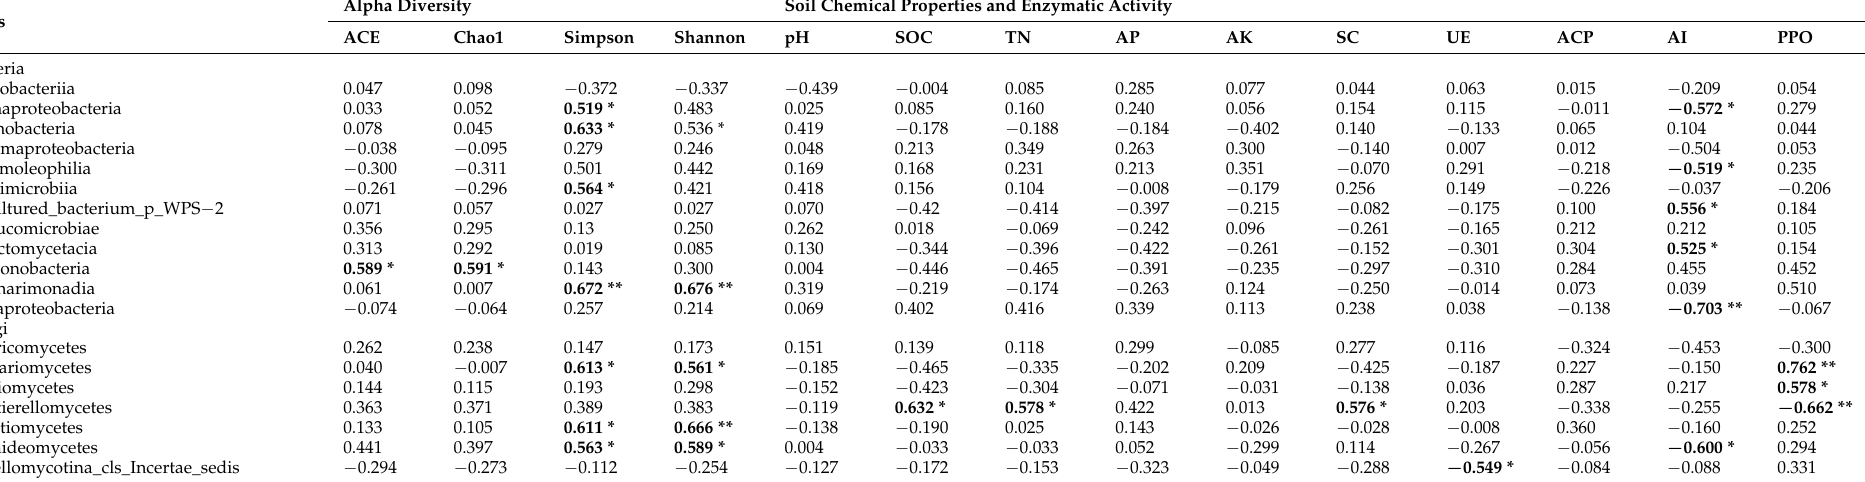
Table 5. Relationships between microbial community at class level and alpha diversity, soil chemical properties, and enzymatic